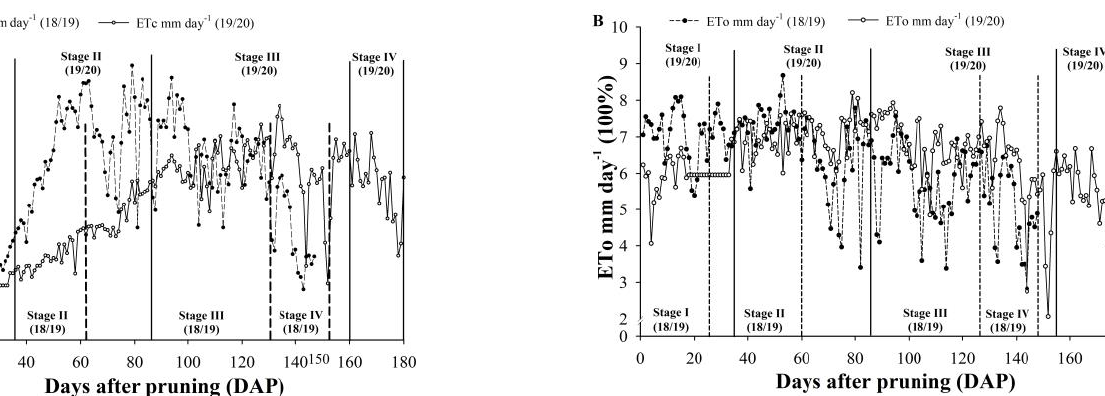
Figure 2. Standard crop evapotranspiration ( A ) (ETc 100% mm day −1 ) and reference evapotranspiration ( B ) (ETo 100% mm day −1 ) in the days after pruning, under semiarid climatic conditions, in the 2018/2019 and 2019/2020 crop years. Stage I — sprouting/initiation of new leaves; Stage II — start of